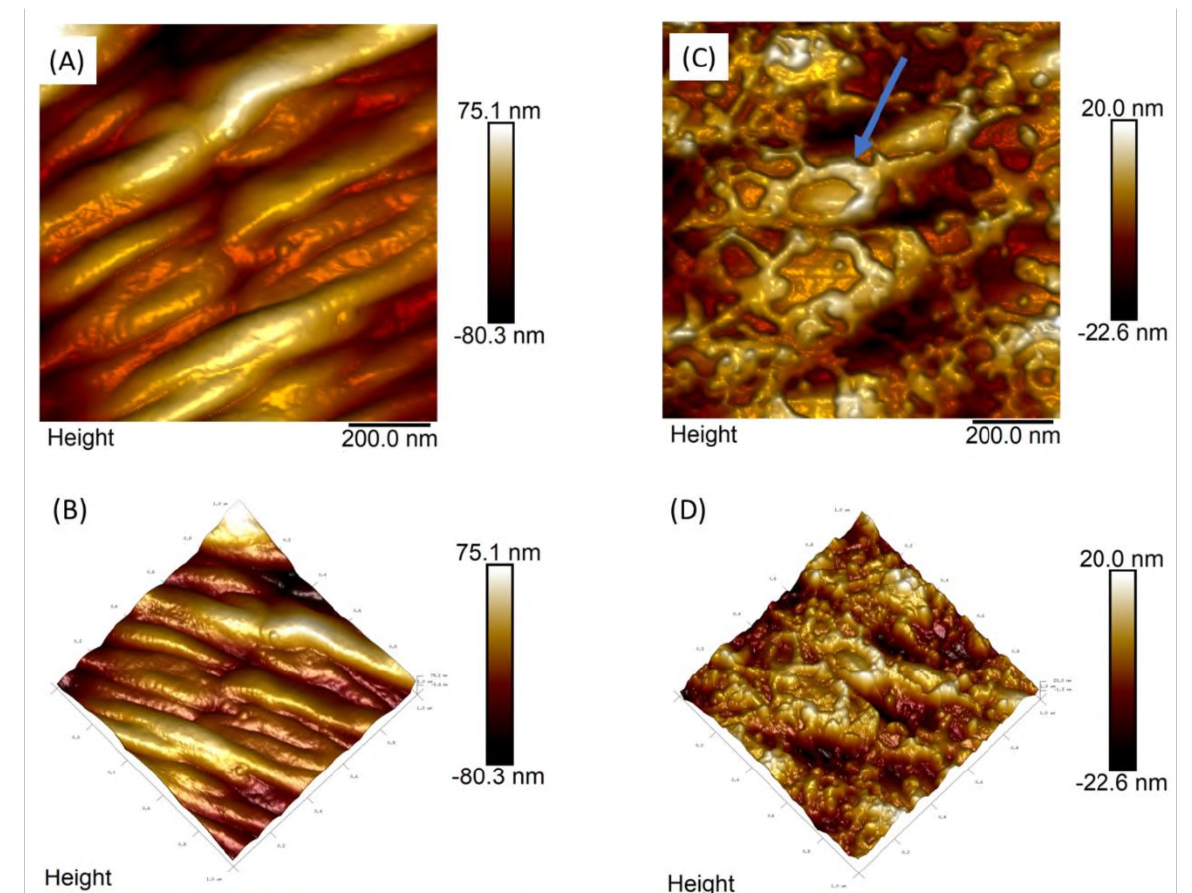
Figure 4. Two-dimensional (2D) and 3D analyses of the L2 cuticle of H. contortus by AFM. Non-treated H. contortus AFM height image in L2 stage ( A ) and its 3D visualization ( B ), H. contortus L2 treated with RcAlb -PepIII ( C ) and its three- dimensional visualization ( D ). In the images ( C , D ), it is possible to observe the alteration promoted by the attachment of the peptide solution to the cuticle in the L2 nematode. The blue arrow points to the presence of structures on the nematode surface observed after their exposure to peptide solution. Both images have a 1 micrometer square